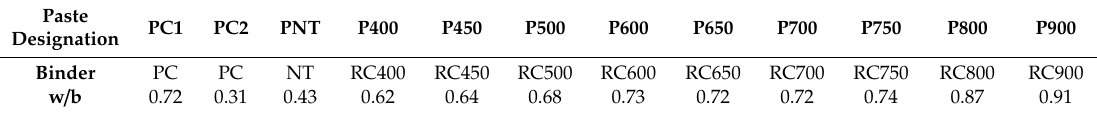
Table 2. Composition of the produced